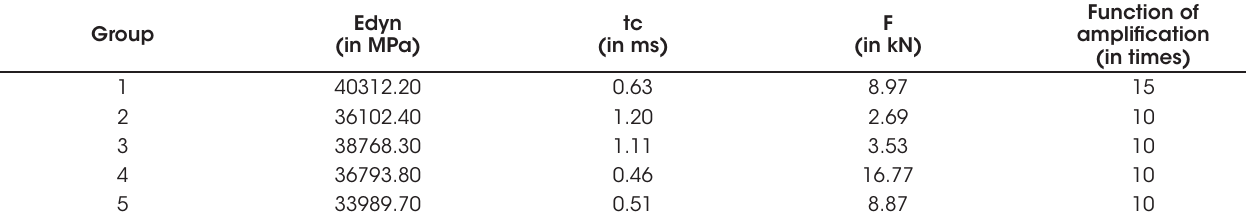
Additional input data